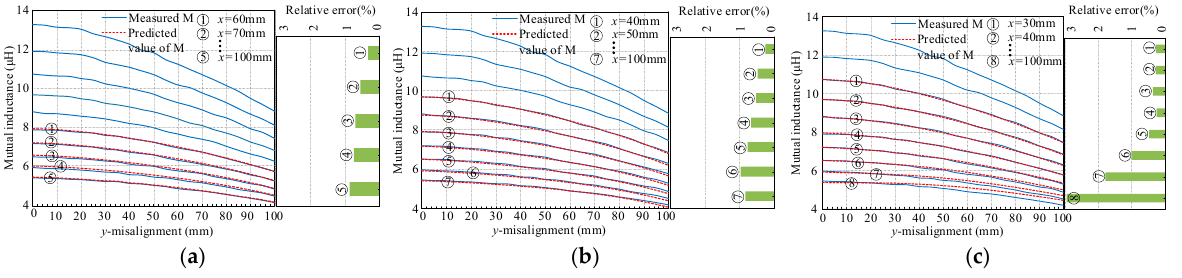
Figure 10. The consistency between the measured and predicted mutual inductance data based on the training data from ( a ) 5 sets; ( b ) 3 sets; ( c ) 2 sets. Table 1. Error analysis of mutual inductance.